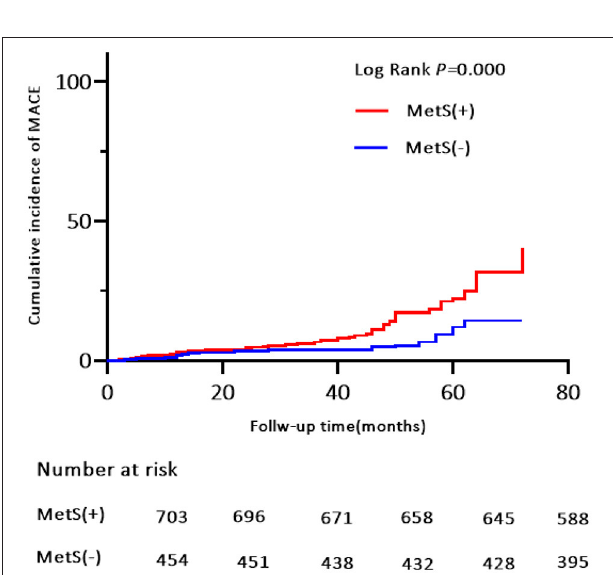
FIGURE 3 | Kaplan-Meier estimates of cumulative incidence (%) for MACE (Primary end points). Log-rank test, P = 0.000. MACE, major adverse cardiovascular